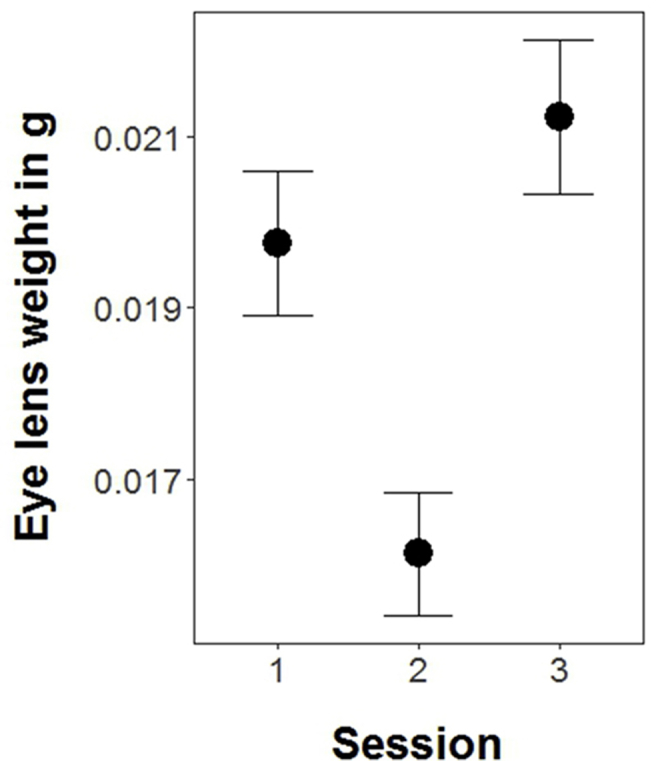
Age differences between experimental sessions. ELW was used as a proxy for host age.